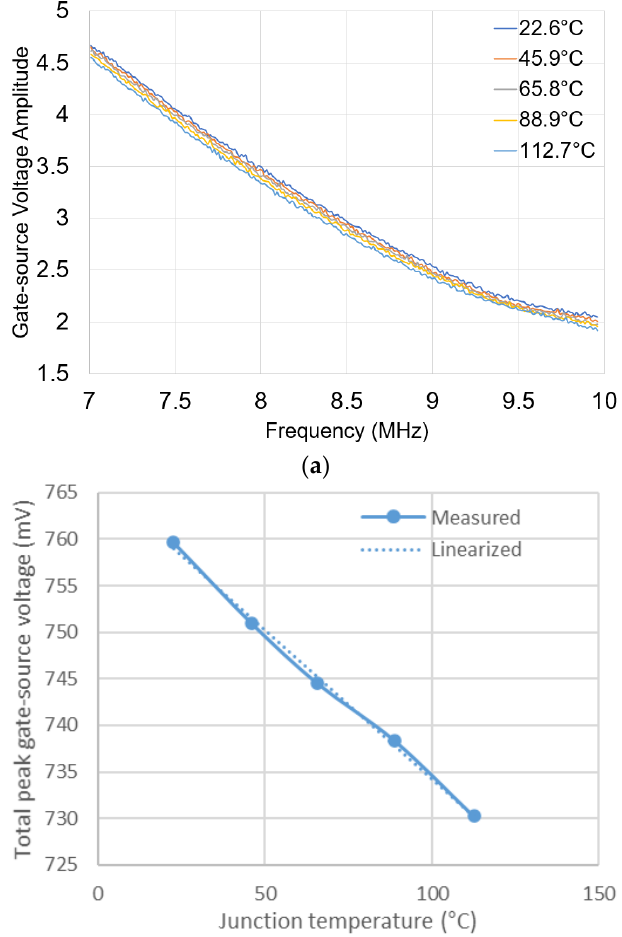
Figure 6. Applying a chirp frequency between 7 and 10 MHz to a 600 V biased SiC MOSFET ( a ) Gate-source voltage amplitude; ( b ) total peak gate-source voltage.